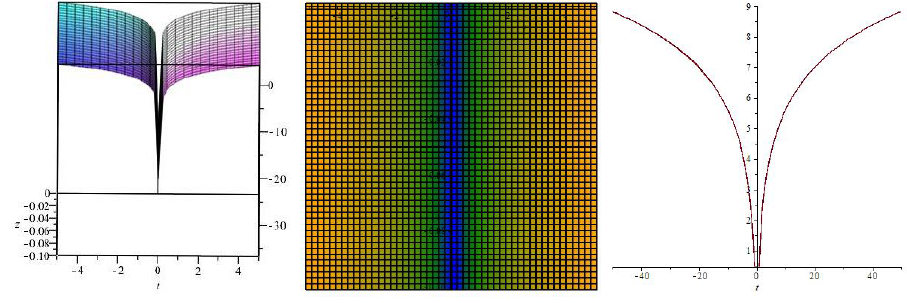
Figure 2. Profiles of solution (15).